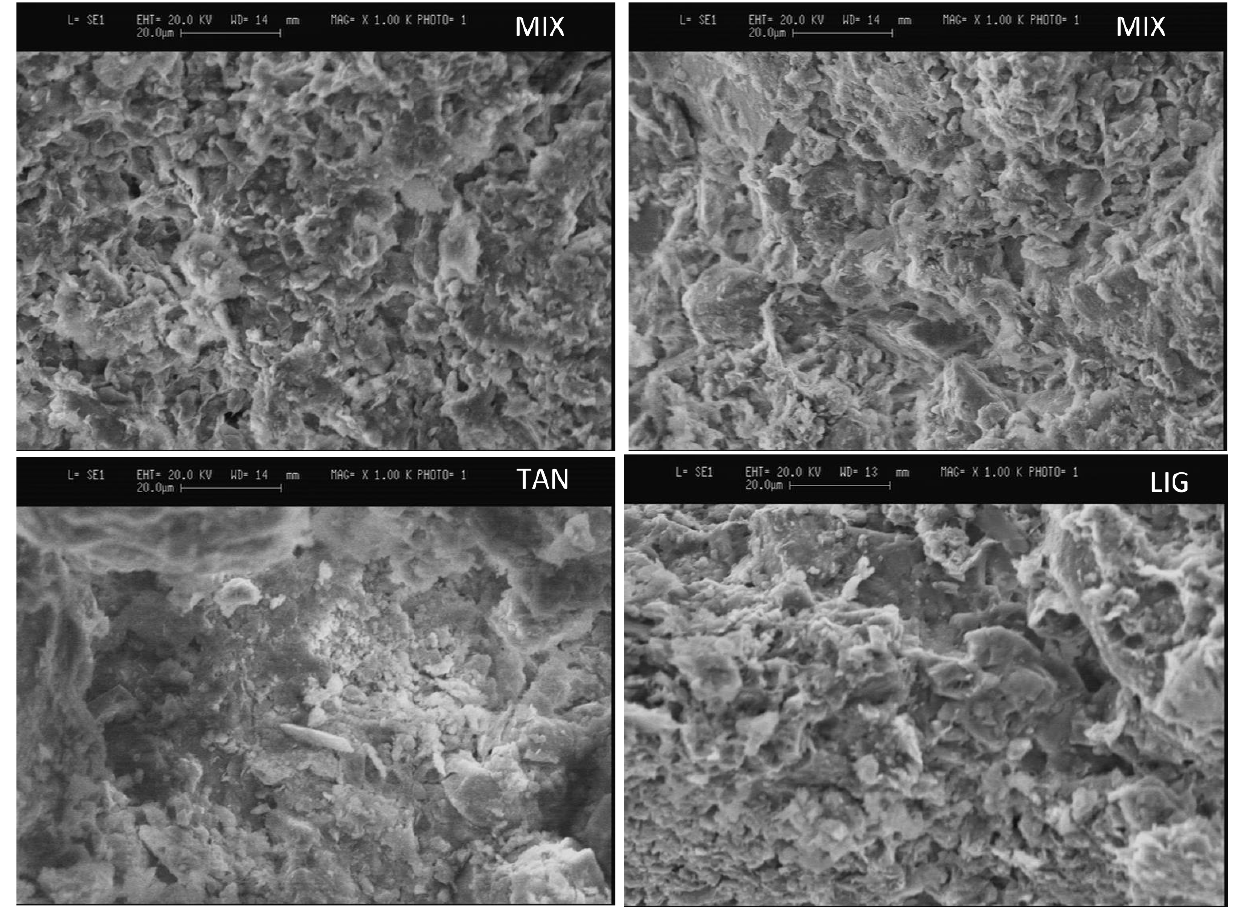
Figure 11. SEM images of MIX, LIG (MIX + 1% lignin sulfonate), and TAN (MIX + 1% tannins); magnification ×1000.